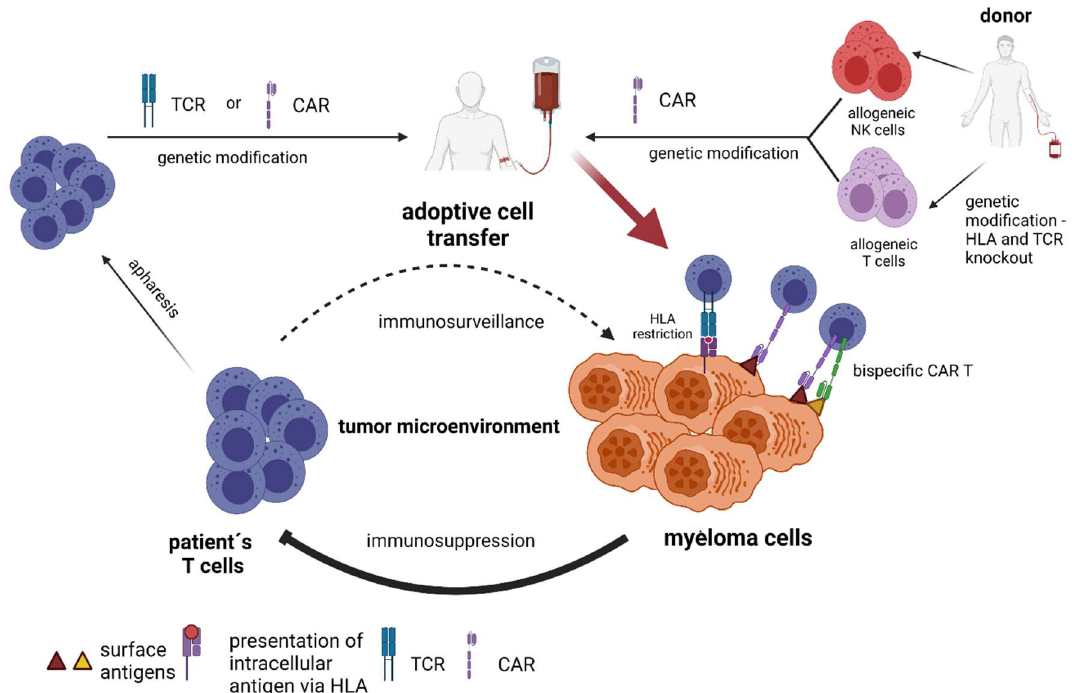
Figure 3. Adoptive immune transfer of autologous and allogeneic lymphocytes with genetic manipulation (TCR-engineered T cells, chimeric antigen receptor T-cells, and chimeric antigen receptor NK-cells).